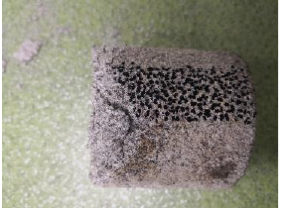
Figure 13. Surface speckle pattern of specimen.